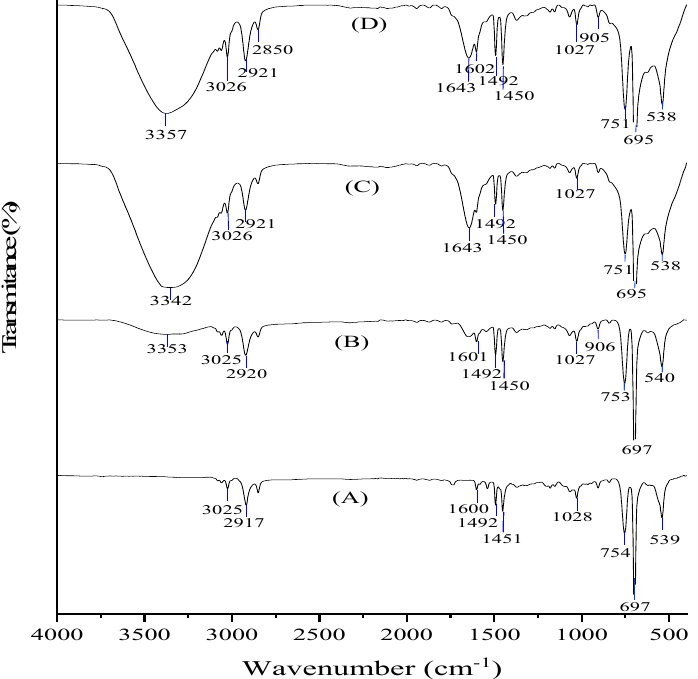
Figure 4. FTIR results of the ratio of Styrofoam ( A ) before treatment, ( B ) 150 mg, ( C ) 250 mg, and ( D ) 400 mg; after 30-day treatment with S. platensis in brackish water culture.